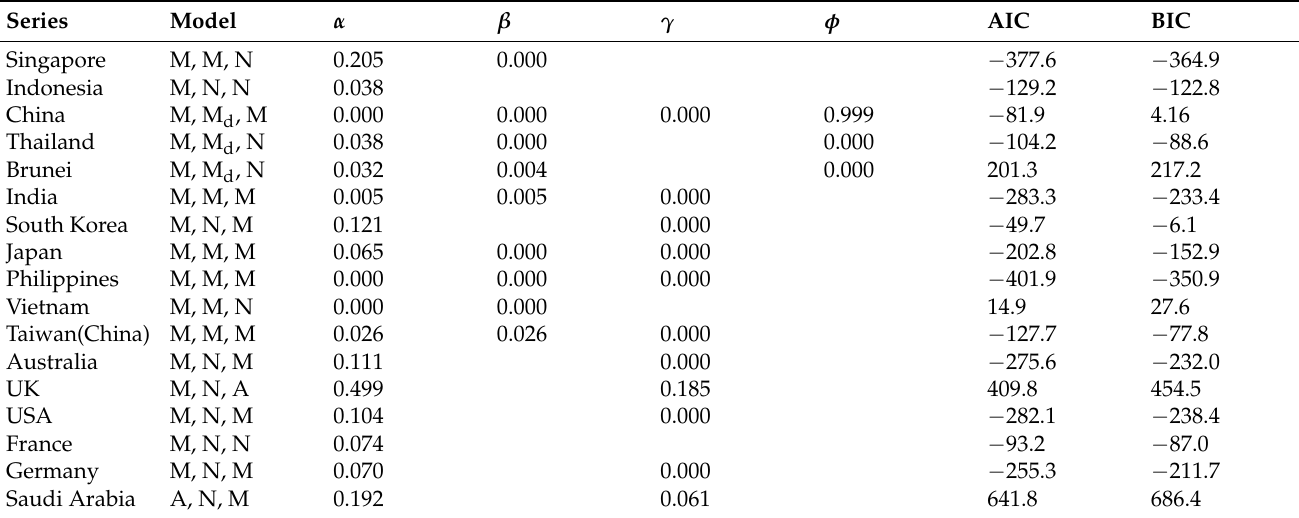
Table 9. The ETS-ES models for 17 source markets.